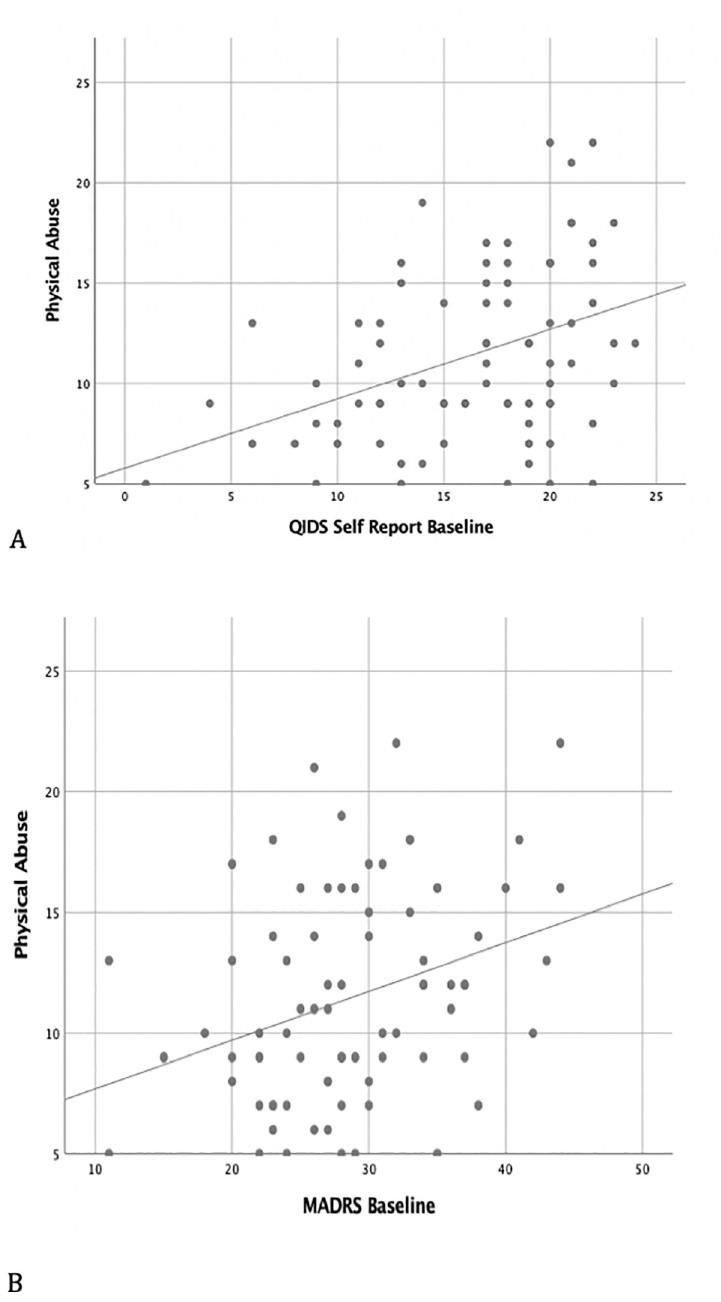
Fig 3. Association between Physical Abuse and intensity of depressive symptoms (A: QIDS-SR; B: MADRS).